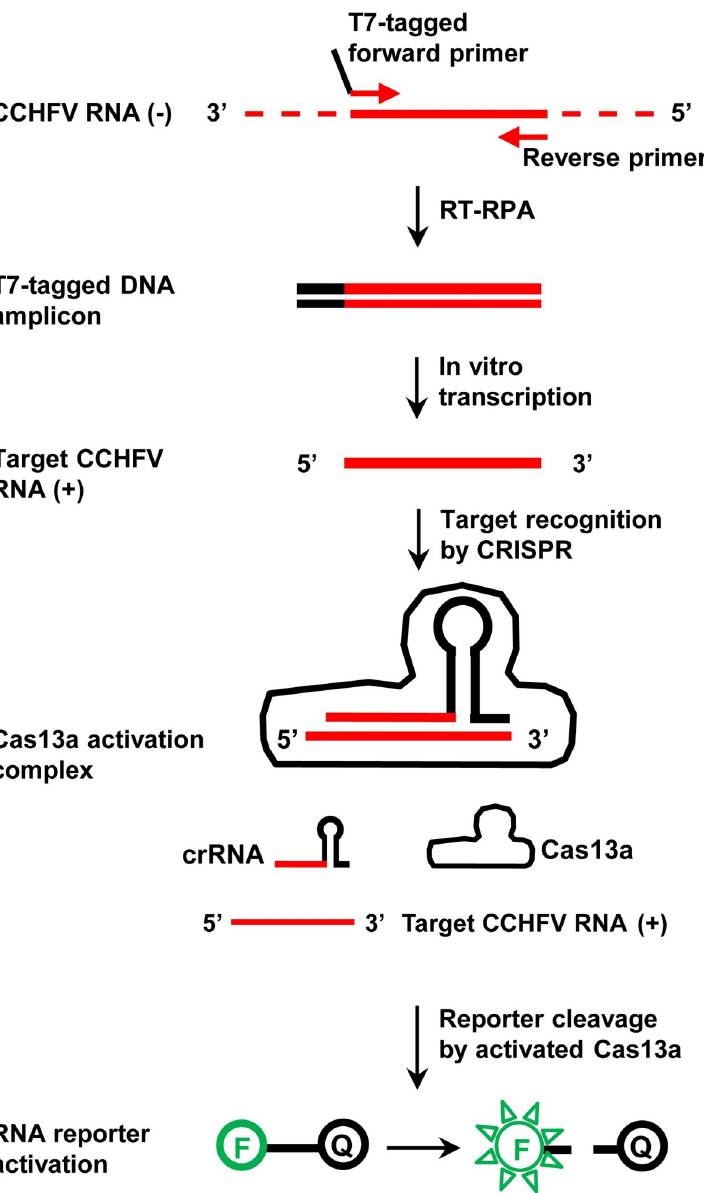
Fig 1. The CRISPR/Cas13a-based diagnostic assay (SHERLOCK) for CCHFV detection. The polarity of an RNA strand is labelled for positive sense (+) or negative sense (-). In the RNA reporter, “F” and “Q” mean fluorophore and quencher,